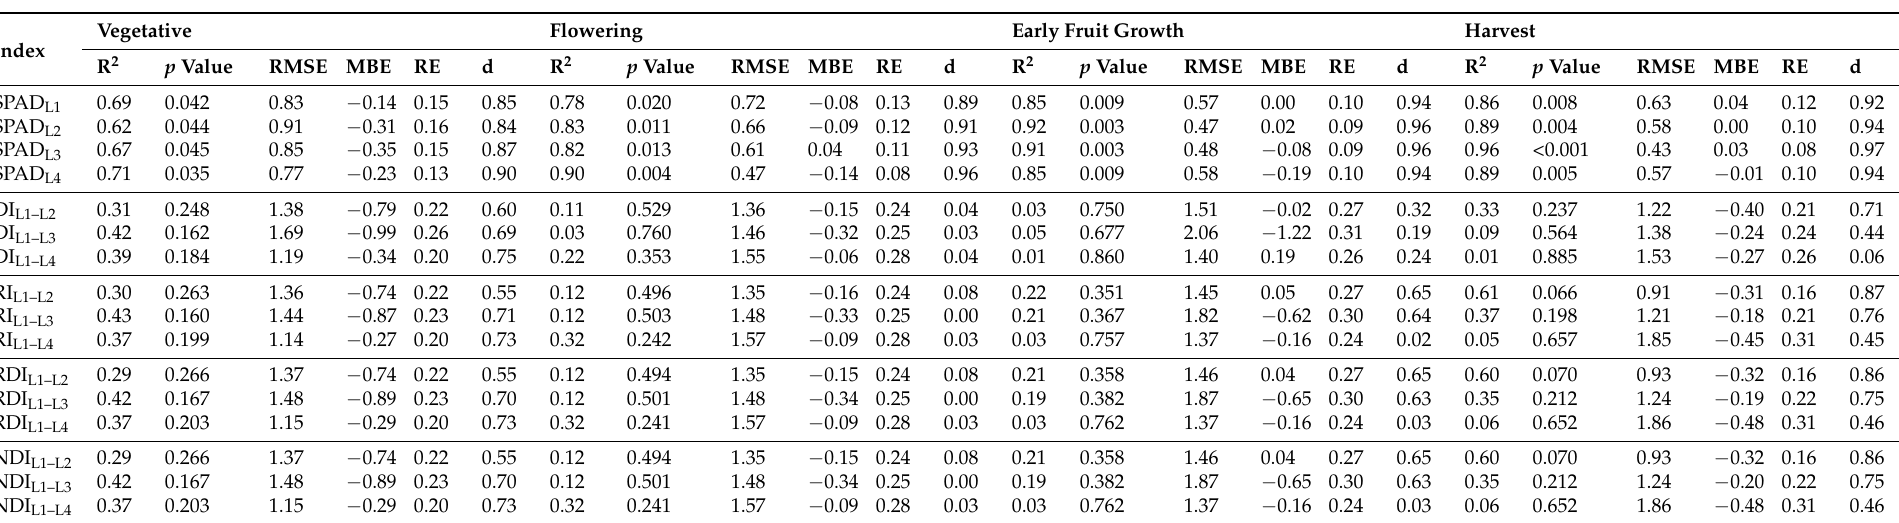
Table 5. Results of the validation analysis of the estimated fruit yield (kg m − 2 ) from SPAD measurements and several normalized SPAD indices (DI, RI, RDI, NDI), at different phenological stages of sweet pepper. DI, Difference Index; RI, Relative Index; RDI, Relative Difference Index; NDI, Normalized Difference Index, R 2 , coefficient of determination; RMSE, root mean square error; RE, relative error; MBE, mean bias error; d, Willmott Index. L 1 , L 2 , L 3 and L 4 , refer to the latest (most recent), second, third and fourth fully expanded leaf,